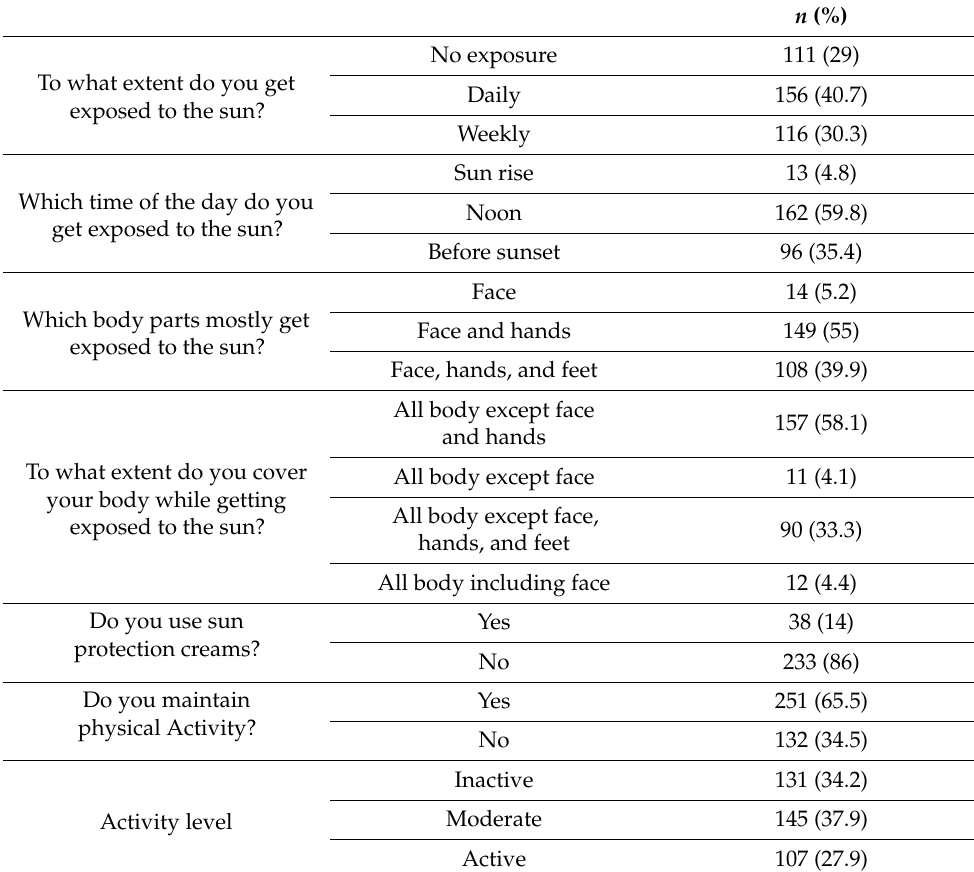
Table 2. Exposure to the sun and physical activity ( n =